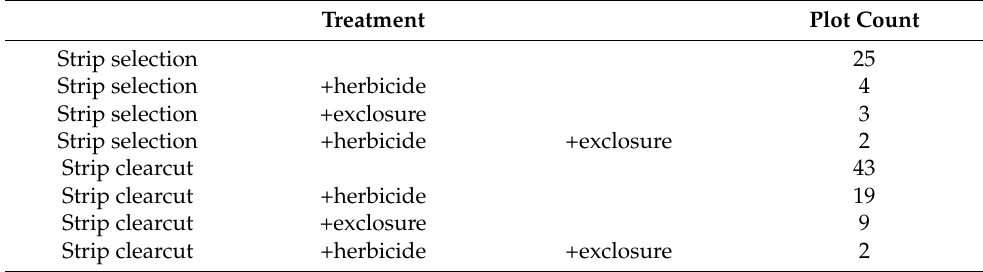
Table 2. Plot distribution among harvest, herbicide, and exclosure treatments in managed northern hardwood forests in the Upper Peninsula of Michigan, USA. Treatment Plot Count